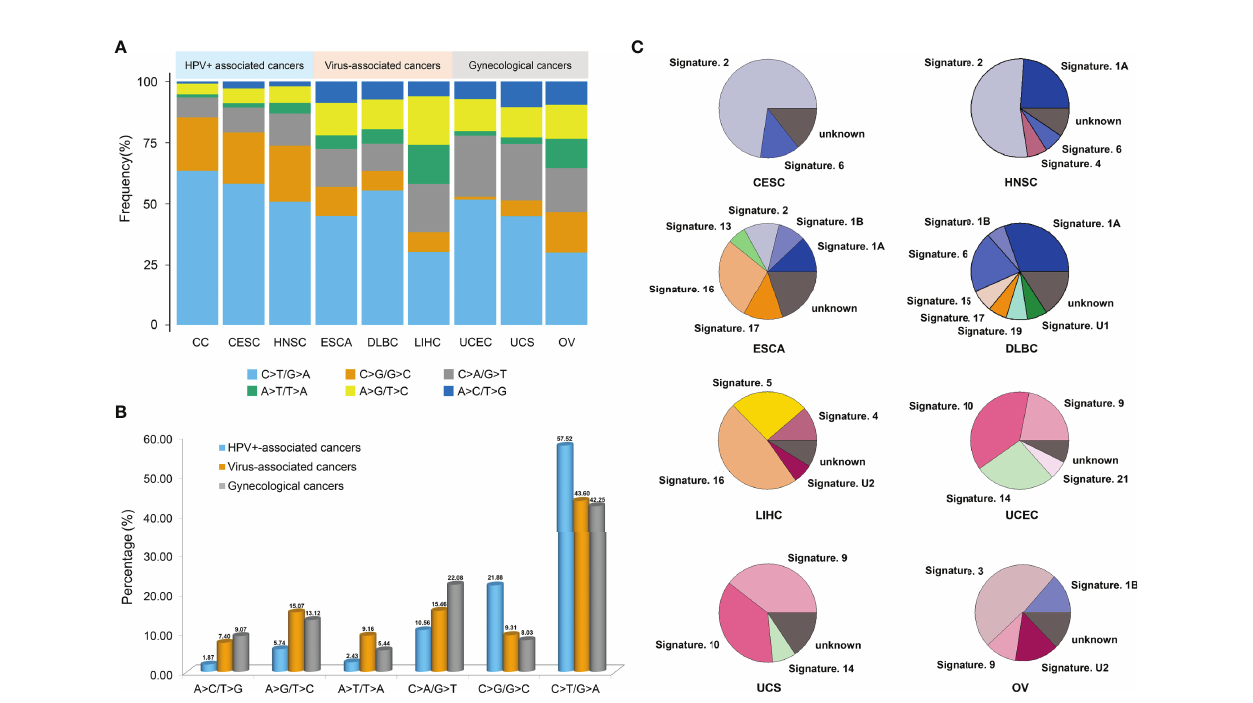
FIGURE 4 | The mutation spectrums and mutational signatures in three different cancer types. (A) Barplots showed the proportion of each substitution subtype in HPV + -associated cancers, virus-associated cancers and gynecological cancers. (B) The average proportion of each substitution subtype in three different cancer types. (C) The proportion of each mutational signatures in HPV + -associated cancers, virus-associated cancers and gynecological